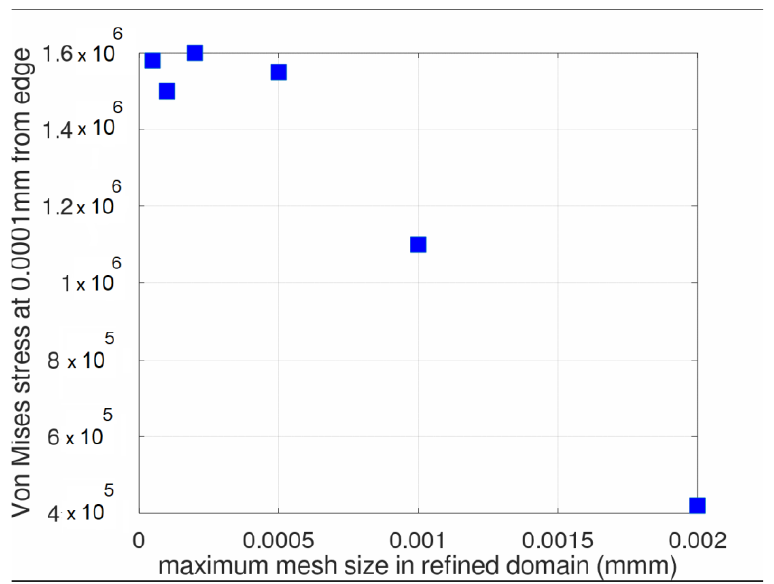
Figure 10. Von Mises stress evolution with the change of the maximum cell size in the domain close to the edge.